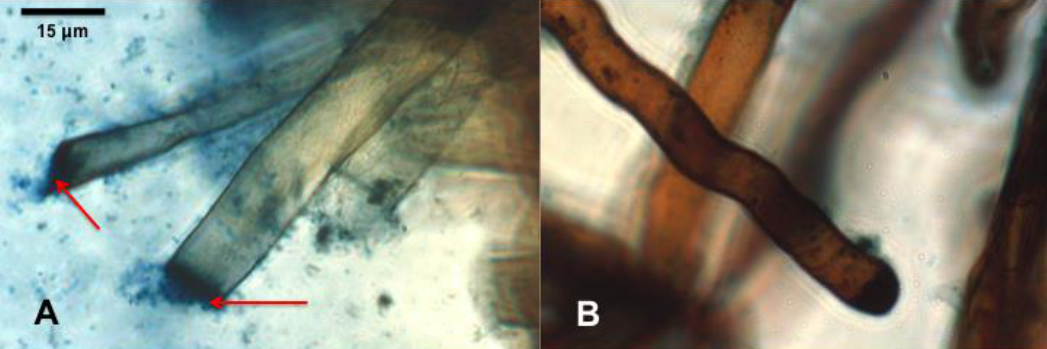
Figure 1. Taraxacum officinale seedling root hairs stained with aniline blue and DAB to visualize reactive oxygen species (H 2 O 2 14 days after seeds were inoculated with a Pantoea sp. (Isolate 4). Root hairs of an inoculated seedling (A) have ruptured while root hairs from a non-inoculated seed (B) are intact (indicated with arrows).